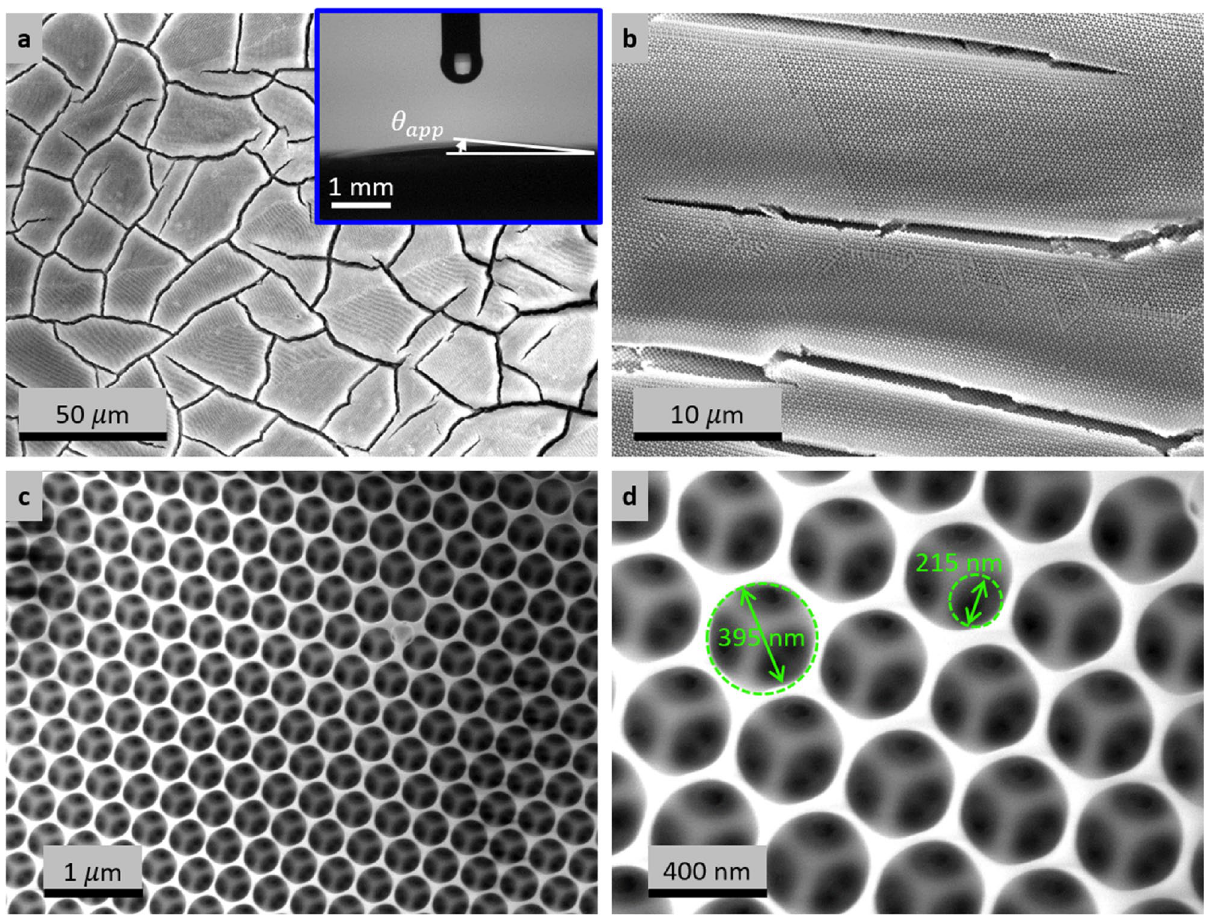
Figure 3. Scanning electron microscope (SEM) images of an inverse opal coating at different magnifications. The low magnification SEM images in ( a ) and ( b ) show fabrication defects (cracks) that formed when the supporting matrix shrank during drying. The inset in ( a ) shows a vanishing contact angle for a water droplet deposited on the porous structure. The high magnification images in ( c ) and ( d ) show the pores which resulted from dissolution of the sacrificial polystyrene beads (≈ 395 nm diameter). The contact points between the polystyrene beads that was not wetted by the solution during co-assembly created interconnected pores (≈ 215 nm